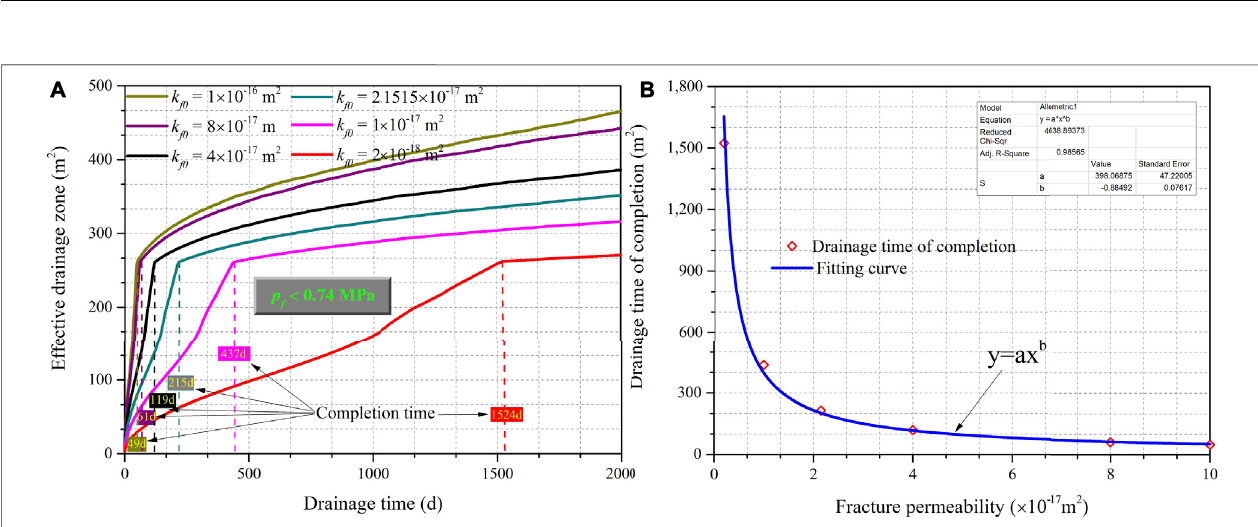
FIGURE 13 | Effect of changes in the coal ’ s fracture permeability, k f 0 , on drainage performance. (A) Effective drainage zone areas vs. drainage time in days. (B) Drainage completion time vs. initial fracture permeabilities.